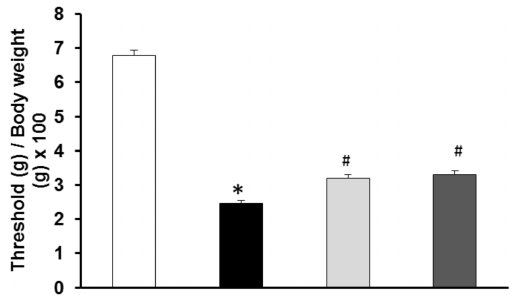
Figure 1. Mechanical sensitivity in 19-week-old rats. Experimental groups: control Zucker lean rats (ZLR, white bar), control Zucker fatty rats (ZFR, black bar), ZFR treated for 12 weeks (from week 8 to week 20) with 750 mg/kg/day of the egg white hydrolyzed with pepsin (light grey bar) and ZFR treated for 12 weeks with 750 mg/kg/day of the egg white hydrolyzed with aminopeptidase (dark grey bar). Bars show means ± SEM. One-way ANOVA was used. * p < 0.05 vs. ZLR, # p < 0.05 vs. ZFR ( n ≥ 9 for all